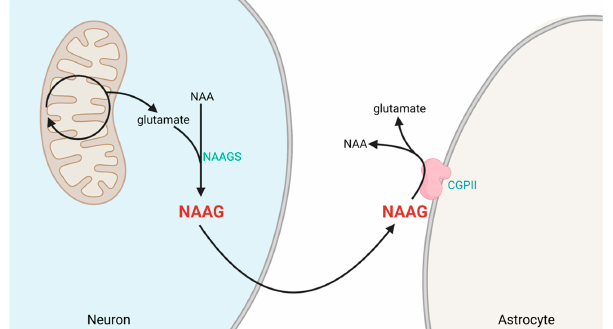
Figure 2. Synthesis and degradation of NAAG in the brain. NAAG is synthesized in neurons from the amino acids glutamate and N-acetyl-aspartate (NAA) via the enzyme NAAG synthetase (NAAGS). NAAG has a short extracellular half-life, as it is rapidly converted back to NAA and glutamate by membrane-bound glutamate carboxypeptidase II (GCPII) on astrocytes. Figure cre- ated with BioRender.